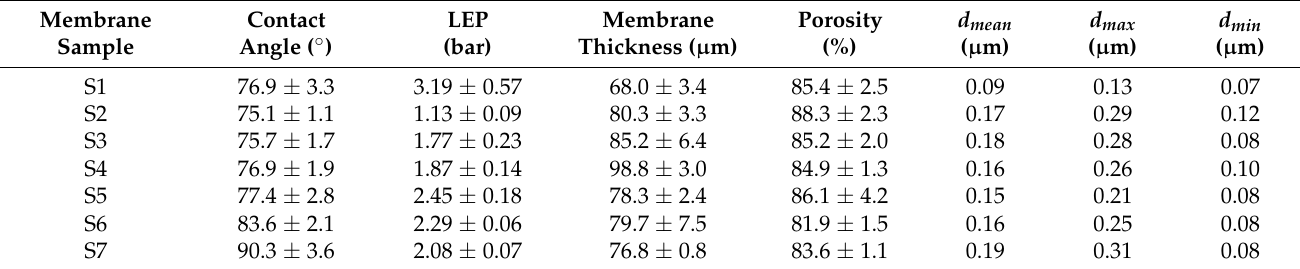
Figure 5. FE-SEM images of cross-section of flat-sheet membranes with different PVDF, LiCl concentration and non-solvent compositions: ( a ) (S1) PVDF 14 wt.% with water, ( b ) (S2) PVDF 14 wt.% + LiCl with water, ( c ) (S3) PVDF 16 wt.% + LiCl with water, ( d ) (S4) PVDF 18 wt.% + LiCl with water, ( e ) (S5) PVDF 16 wt.% + LiCl with water (90%) + EtOH (10%), ( f ) (S6) PVDF 16 wt.% + LiCl with water (80%) + EtOH (20%) and ( g ) (S7) PVDF 16 wt.% + LiCl with water (70%) + EtOH (30%). Table 2. Primary (measurable) properties of fabricated